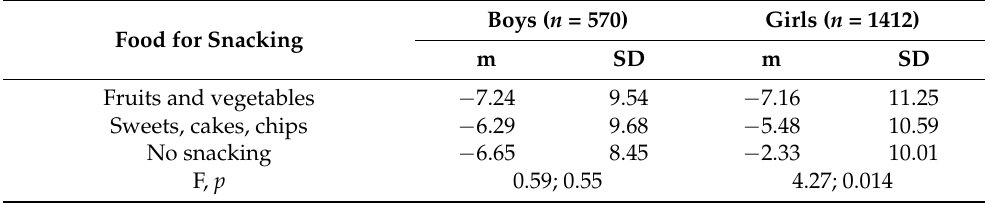
Table 2. The comparison of self-objectification in the groups of snacking habits in adolescent boys and girls ( n =